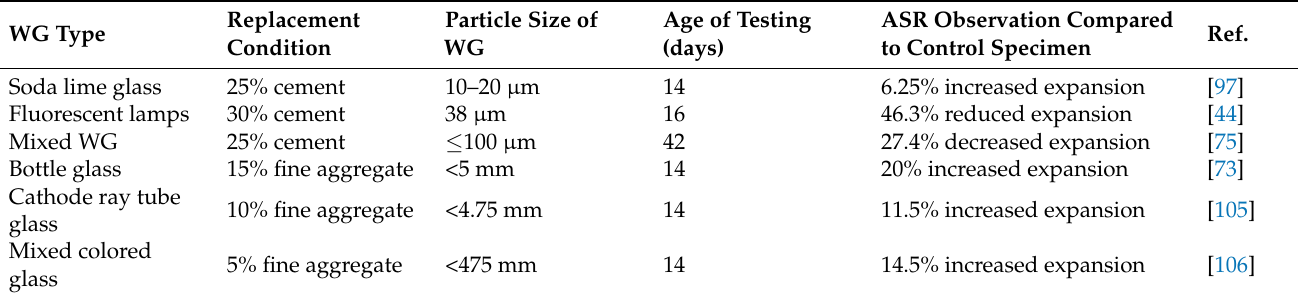
Table 5. ASR expansion of WG-based cementitious